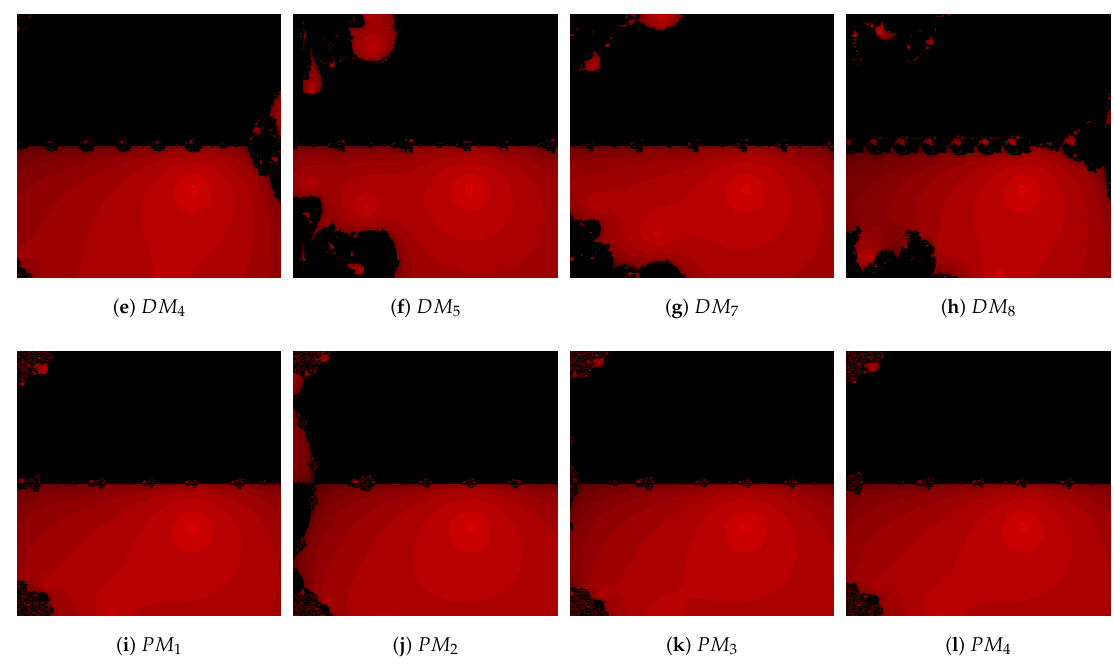
Figure 5. Comparisons of the convergence plane at β = − 0.01 for Problem